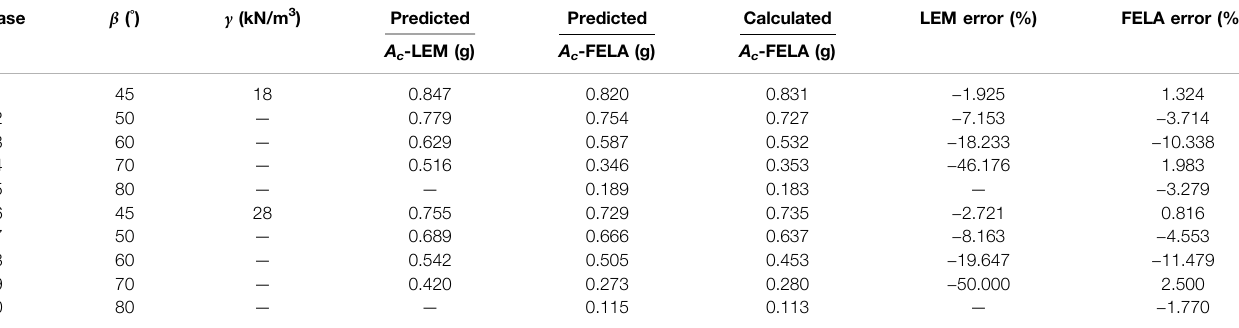
TABLE6| Comparisonbetweentheresultsofpredicted A c andFELAsimulationfordifferentunitweightsandslopeangles ( Note: GSI is40, m i is25, H is30 m, σ ci is10 MPa).